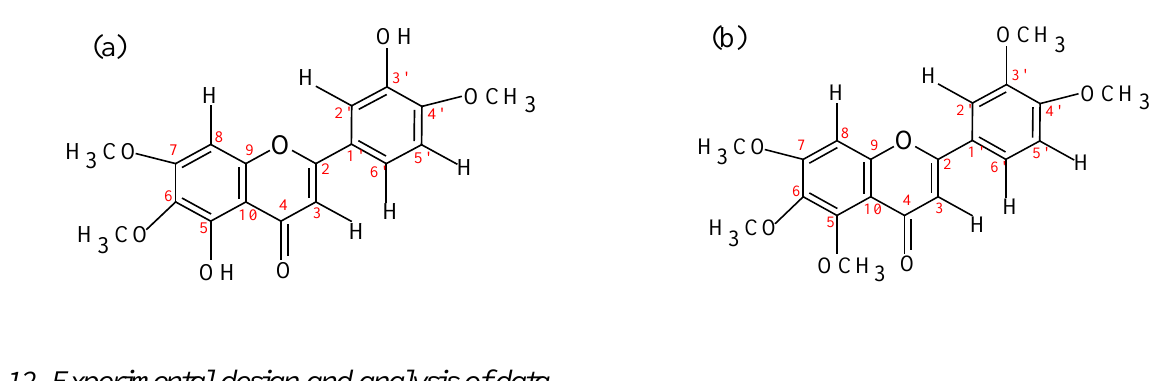
Figure 7. Chemical structure of isolated compounds. (a) 5,3’-dihydroxy-6,7,4’-trimethoxy- flavone (eupatorin), (b) 5,6,7,3’,4’-pentamethoxyflavone